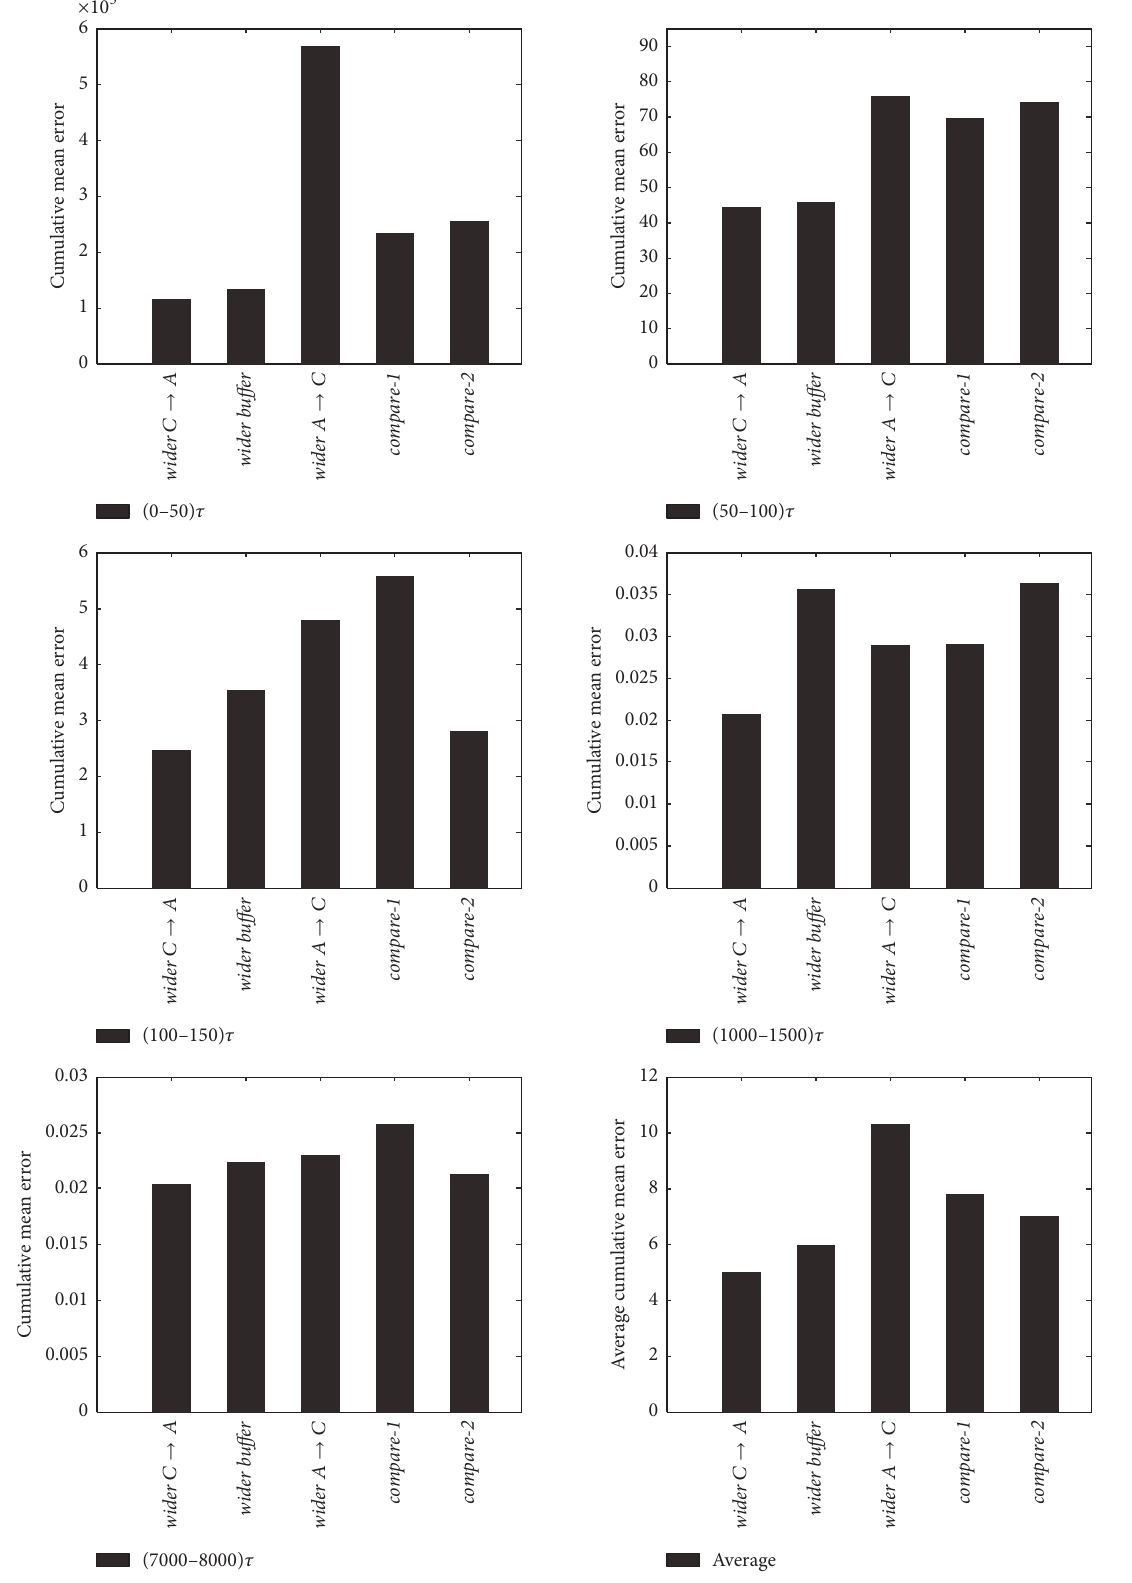
Figure 11: Cumulative mean errors during five time intervals (0–50) 𝜏 , (50–100) 𝜏 , (100–150) 𝜏 , (1000–1500) 𝜏 , and (7000–8000) 𝜏 and final average